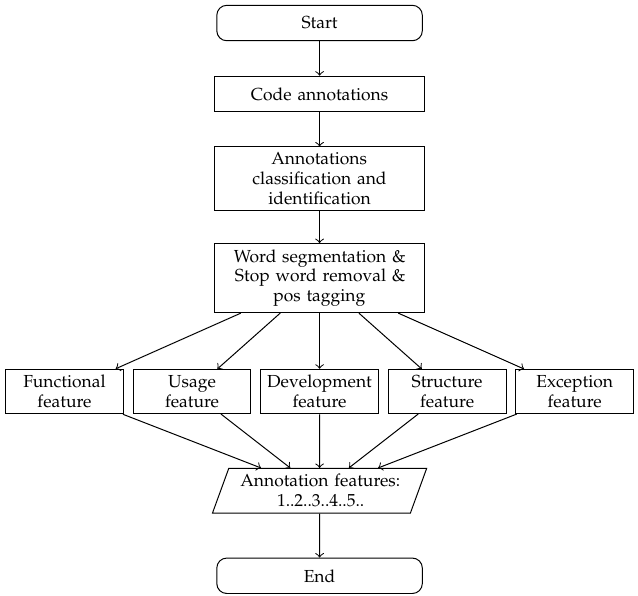
Figure 4. Code Annotation